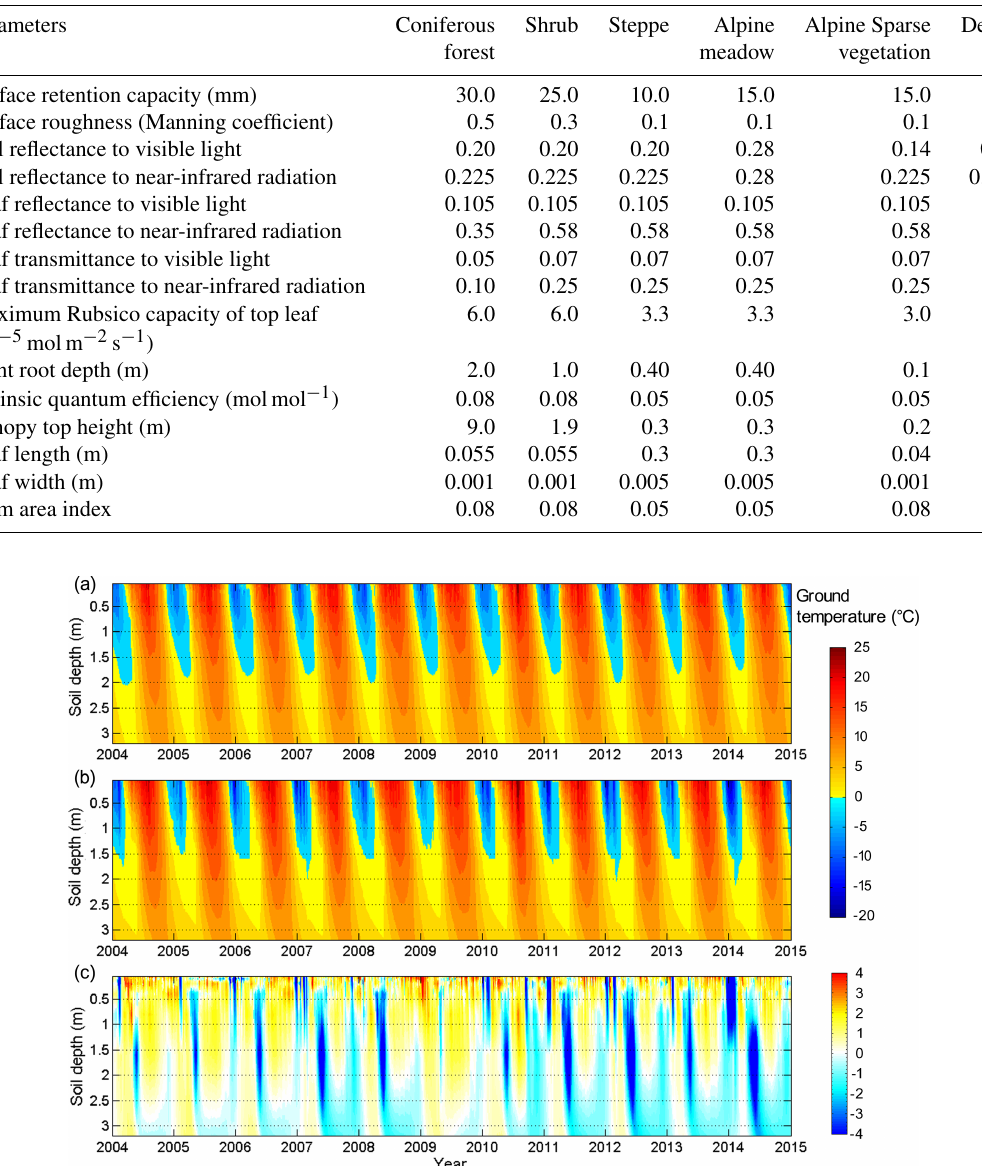
Figure 4. Daily soil temperature at the Qilian station: (a) observation; (b) simulation; (c) difference (simulation −